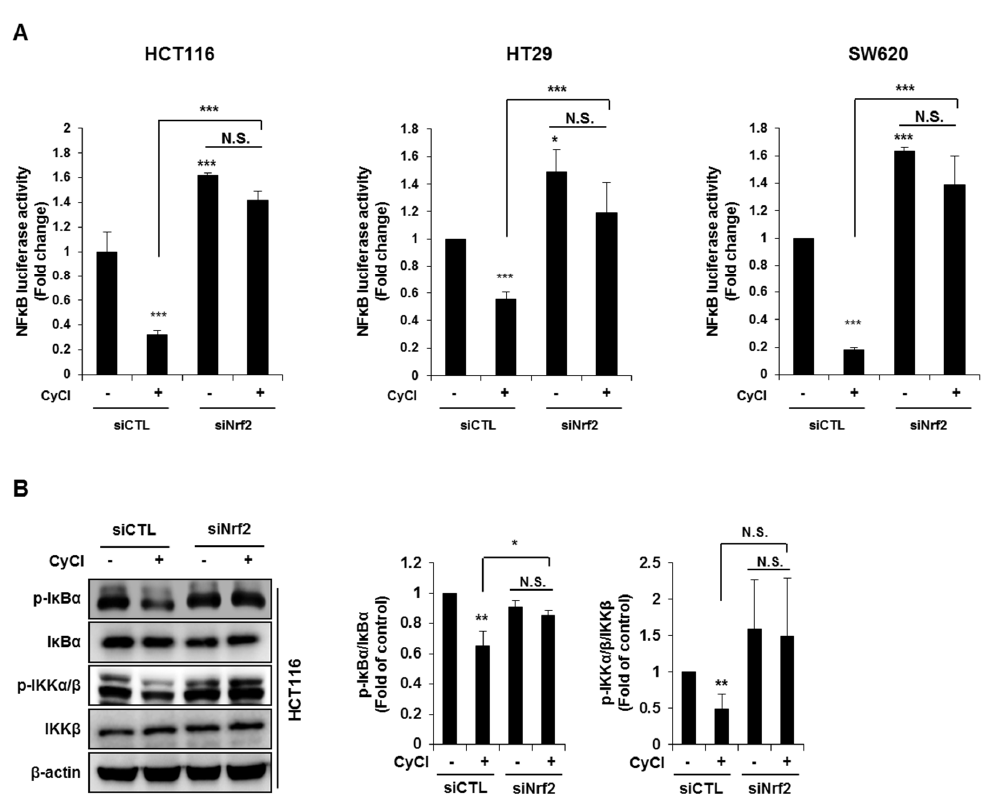
Figure 7. Nrf2 knockdown abrogates the suppression of NF- κ B signaling induced by CyCl. ( A ) The NF- κ B-response-element-Luc reporter was cotransfected with Nrf2 siRNA into colon cancer HCT116, HT29, and SW620 cells. After 24 h, cells were treated with or without 50 µM of CyCl. After 24 h, cells were lysed for the luciferase assay. ( B ) HCT116 cells were transfected with control or Nrf2 siRNA. After 24 h, cells were treated with 50 µM of CyCl for 24 h. Western blot analysis was performed for the levels of p-I κ B α , I κ B α , p-IKK α / β , and IKK β protein. All experiments were carried out in triplicate. * p < 0.05, ** p < 0.01, and *** p < 0.001, significantly different compared with empty vector-transfected control.